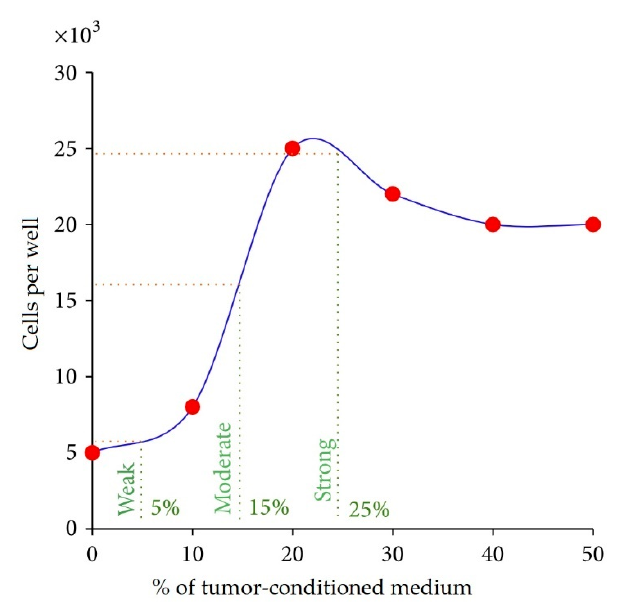
Figure 6. Dose determination of tumor-conditioned medium used to prepare HMECs with tumor-induced cell surface profiles. HMEC cultures were incubated with 0%, 10%, 20%, 30%, 40%, or 50% tumor-conditioned medium. After three days in culture, cells were counted (red points) in wells using trypan blue exclusion. Cell numbers were approximated using a curve used to determine the concentrations of the tumor-conditioned medium that elicited either weak (stimuli slightly higher than in the control), moderate (half of the maximum), or strong (maximum) stimulation of HMEC cultures (green lines). Green line labels indicate the percentage of the tumor-conditioned medium selected for CTA. Adapted from [92].